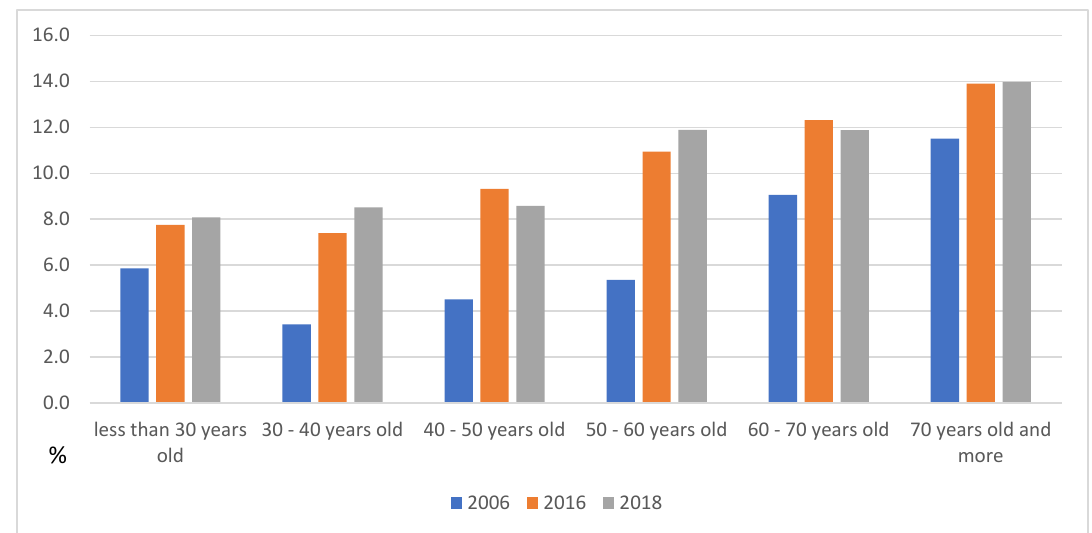
Figure 1. Share of energy expenditure in disposable income in households by age of the person running the household in Poland in 2006, 2016, and 2018. Source: own elaboration based on data from [72–74].